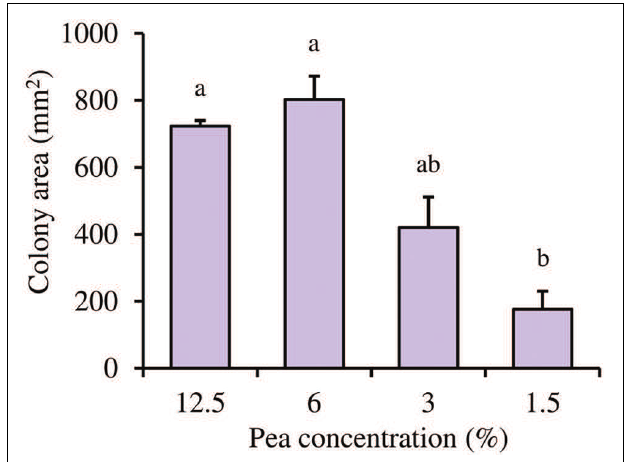
FIGURE 5 | Influence of pea concentrations on Lysobacter capsici AZ78 motility. The motility of Lysobacter capsici AZ78 was monitored on Pea Agar Medium (0.5% Agar) containing 12.5, 6.0, 3.0, and 1.5% frozen peas. An F -test revealed non-significant differences between experiments ( P = 0.84), and data from the three experiments were pooled. Mean colony area (mm 2 ) and standard error values were calculated as the pool of nine replicates (Petri dishes) from three experiments. Different letters indicate significant differences according to Tukey’s test ( α =